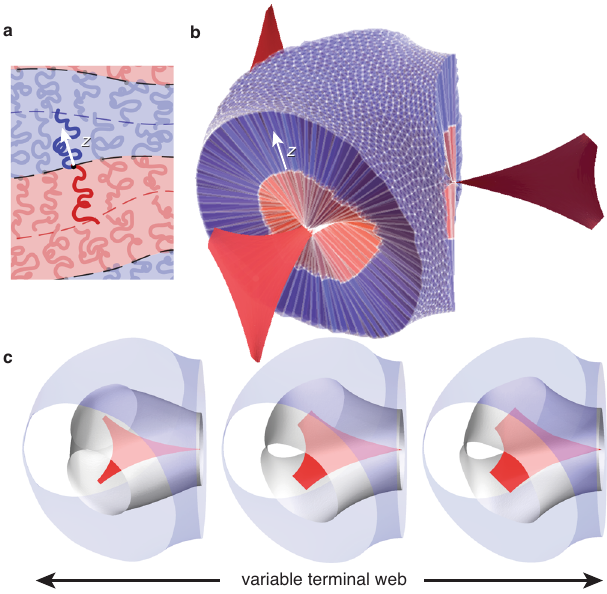
Fig. 2 Subdomain tessellations for strong-segregation chain packing. Schematic of chain packing within a variably-shaped morphology is shown in ( a ) where z labels local extension of blocks from the IMDS. b Shows a (volume balanced) tessellation of the nodal region of DG, generated via the medial SST construction. c Shows a sequence of medial SST geometries (at fi xed composition f = 0.3) highlighting lateral spreading of terminal webs achieved via parametric variation of DG generating surfaces (as described in the